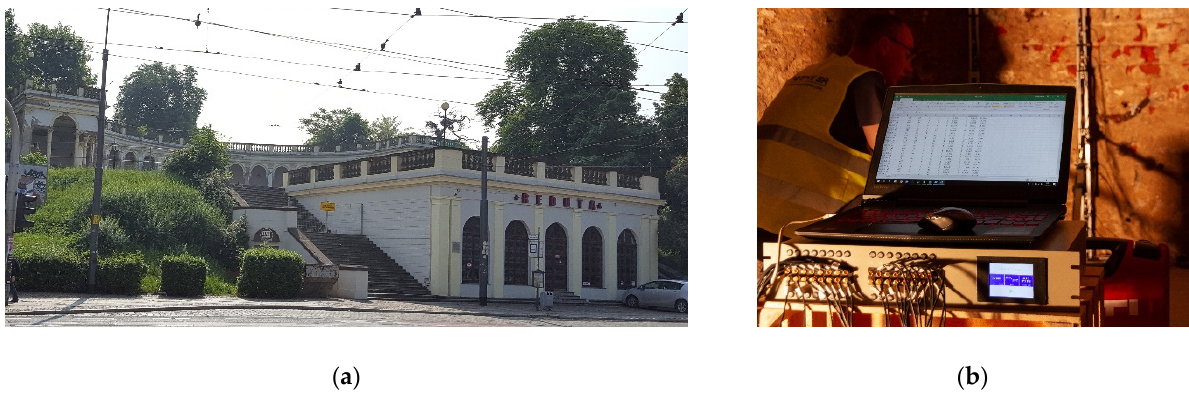
Figure 1. Research object—Bastion Sakwowy in Wrocław: ( a ) lower building (Peristyle Pavilion) where the research was carried out, ( b ) a research stand with a tomograph in the foreground.